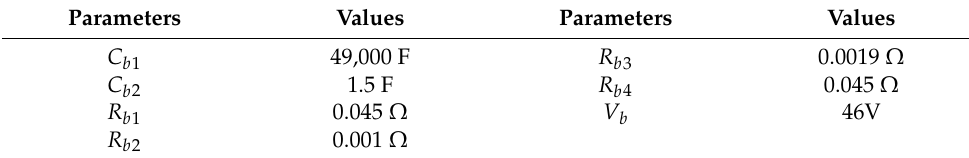
Table 5. Parameters of